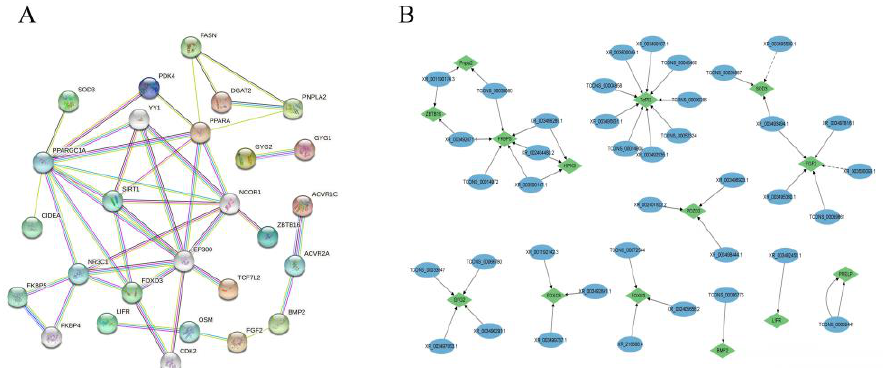
Figure 5. The interaction between DE lncRNA and its target genes as well as DEGs. Note: ( A ) Protein–protein interactions of genes and target genes of differential lncRNAs. Note: ( B ) Interactions between lncRNAs and target genes.